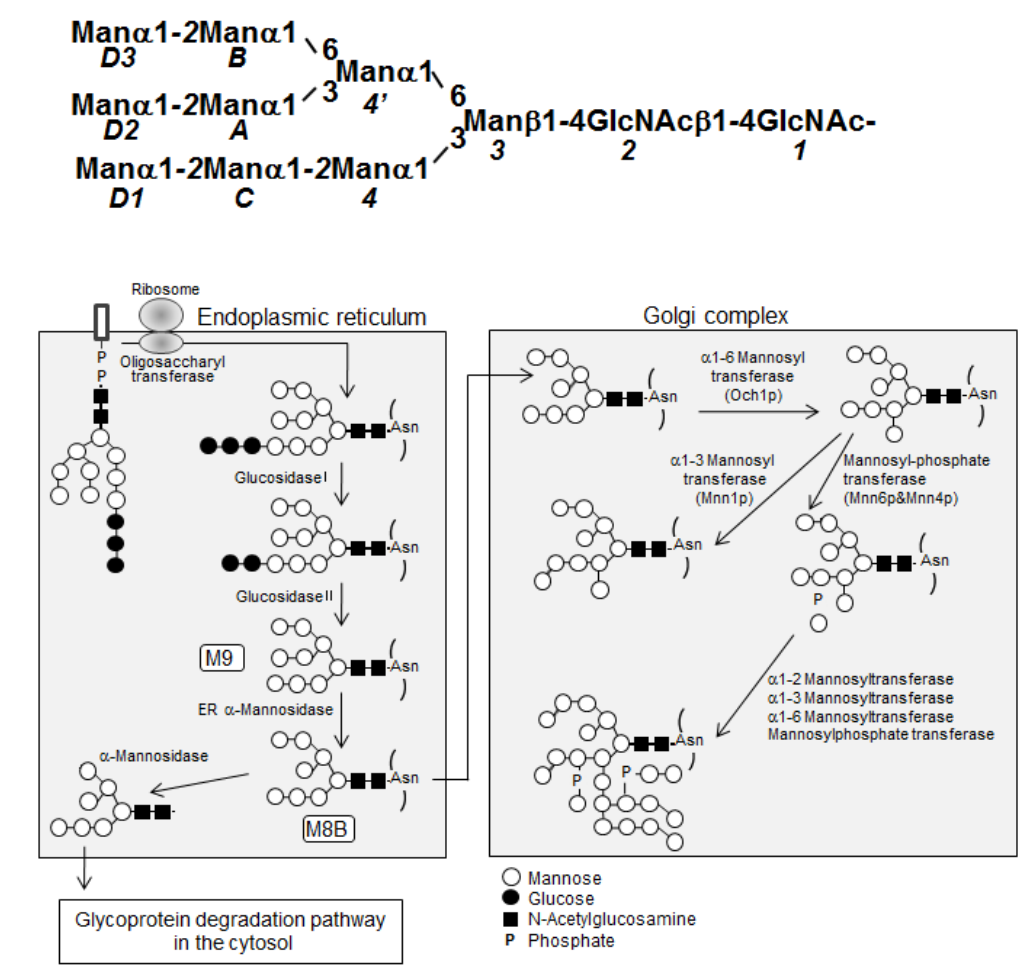
Figure 1. (a) Schematic representation of Man patterns, together with the residue numbering scheme. (b) Scheme showing the processing pathway of N -linked oligosaccharide (adapted from reference [11] with modifications).